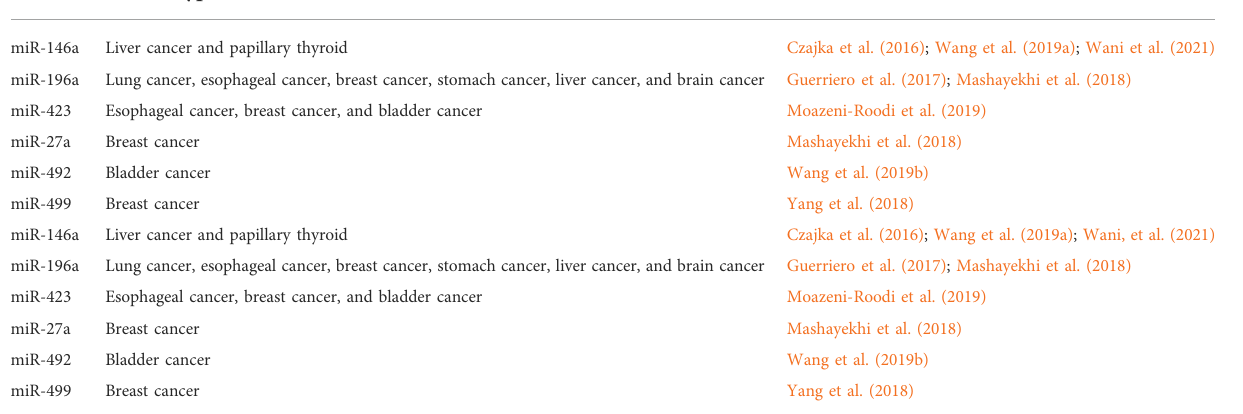
TABLE 2 miRNA expression in different types of cancer. miRNA Cancer